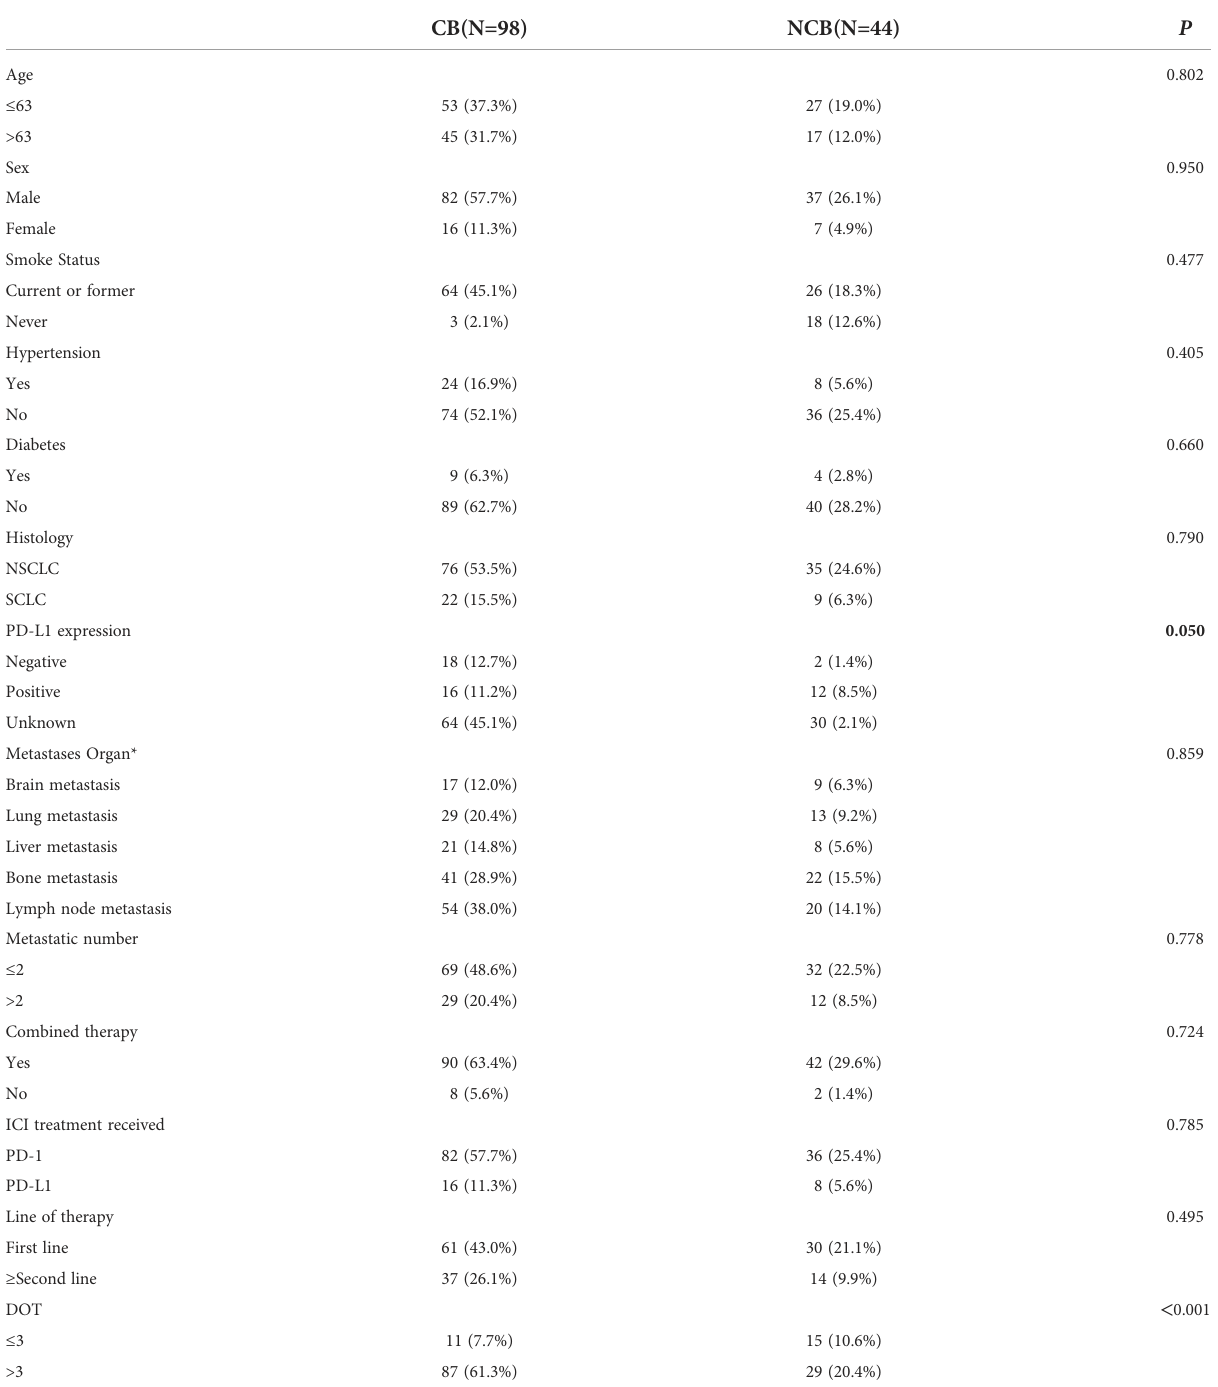
TABLE 6 Relationship between clinicopathological characteristics and clinical response ef fi